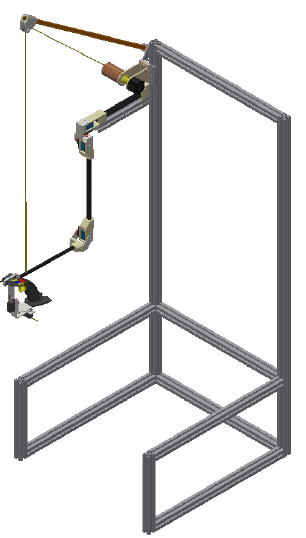
Figure 2. The prototype 3D model of